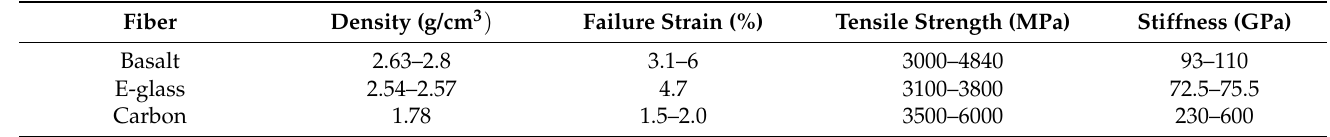
Table 1. Material properties of different fiber